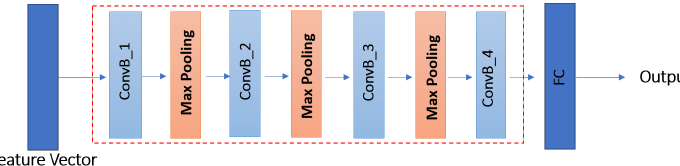
Figure 3. Linear convolutional neural network model used a backbone in Siamese